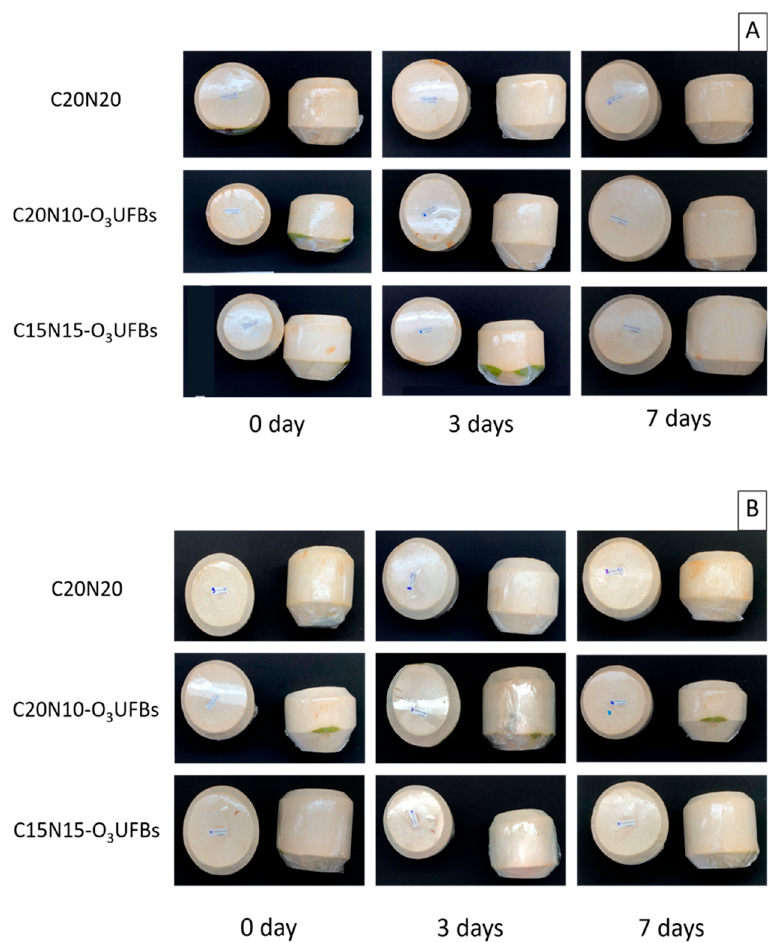
Figure 2. Trimmed coconuts dipped in C 20 N 10 -O 3 UFBs and C 15 N 15 -O 3 UFBs compared with C 20 N 20 when stored at 2 ◦ C for 0 day (before storage) ( A ) and 30 days ( B ). After storage, all coconut